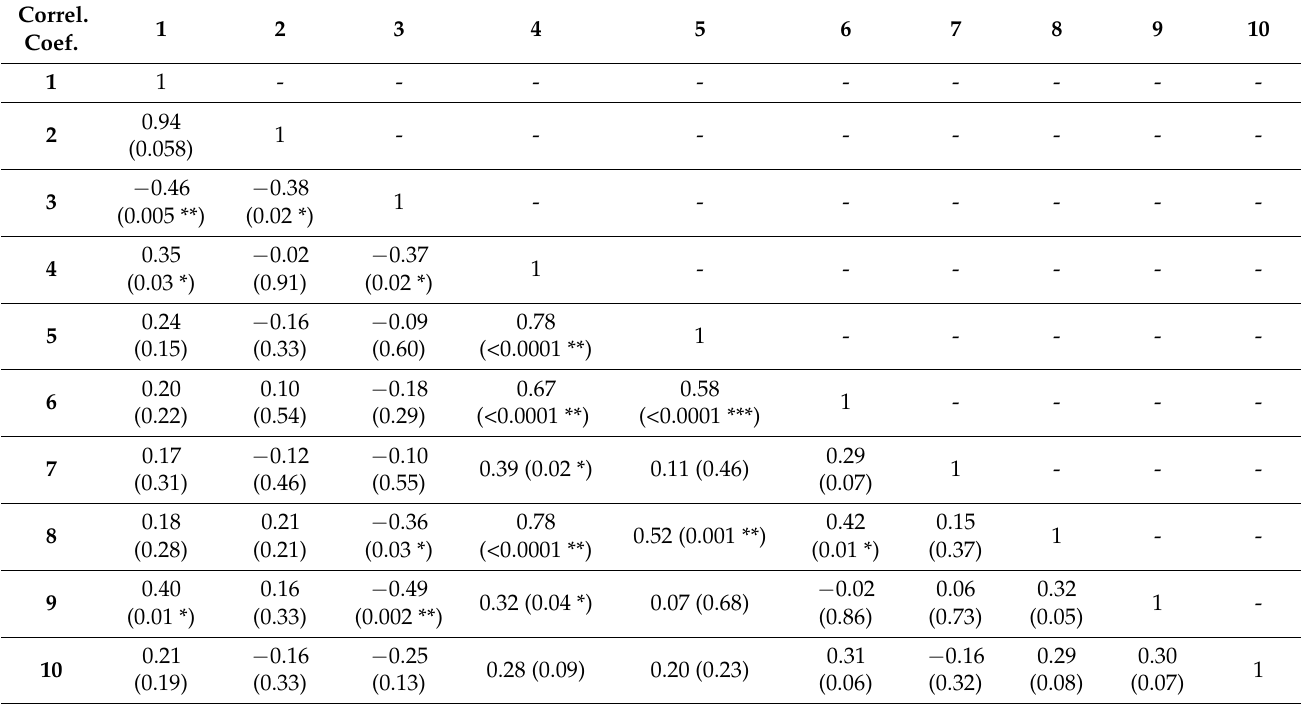
Table 4. Correlation coefficients and their statistical significance for RMET, EQ, BPRS and MoCA scores for the PAT sample.